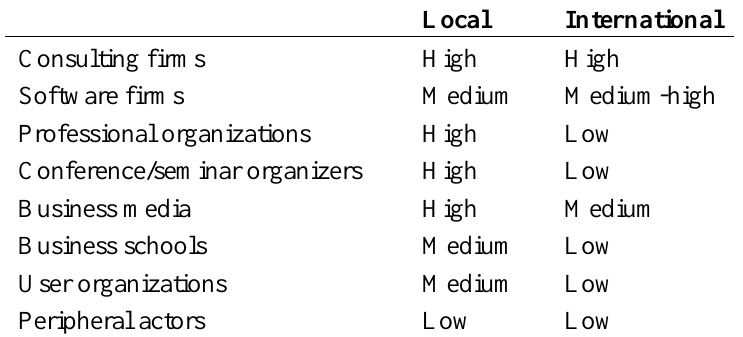
Table 6. The importance of local and international actors